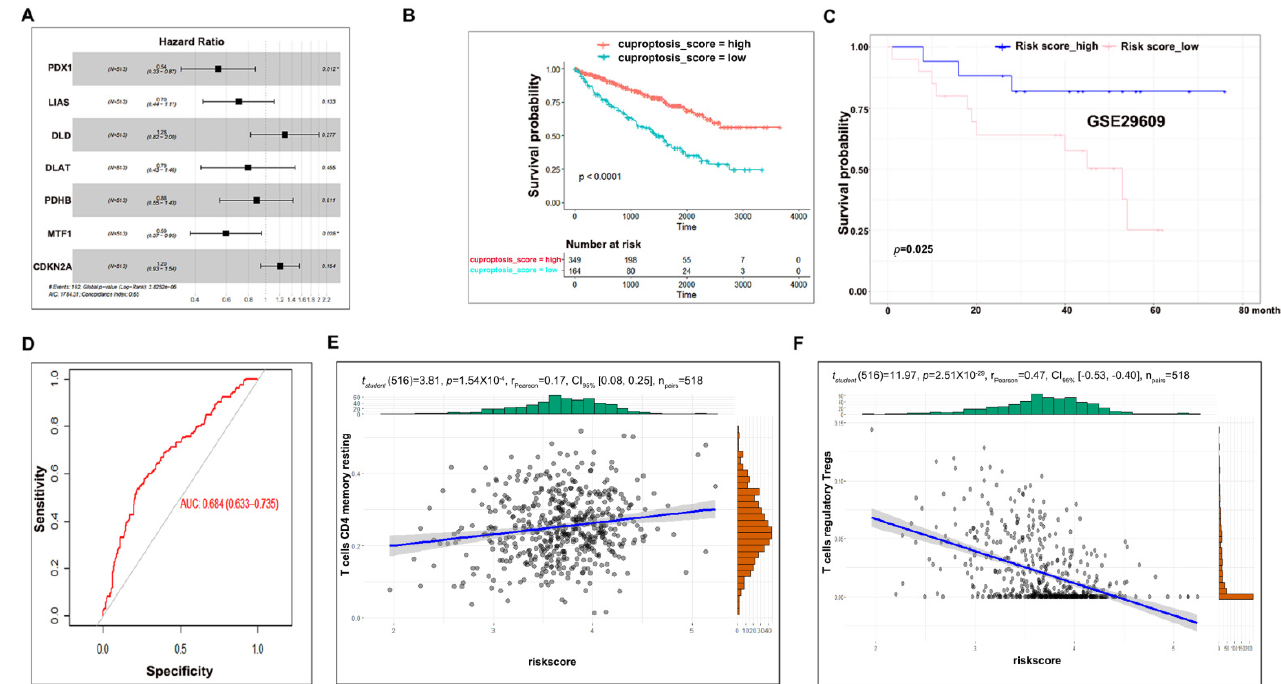
Figure 3. Cuproptosis risk score has a prognostic value in ccRCC. ( A ) Multivariate Cox regression analysis of seven cuproptosis regulators. ( B ) Cuproptosis_score high patients harbored longer survival as compared to cuproptosis_score low controls. ( C ) A fitness test of cuproptosis risk score in another independent dataset. ( D ) AUC analysis to evaluate the analysis of C. ( E ) Correlation between the CD4+ T memory resting cell population and the cuproptosis risk score. ( F ) Correlation between the T regulatory Treg cell population and the cuproptosis risk score.